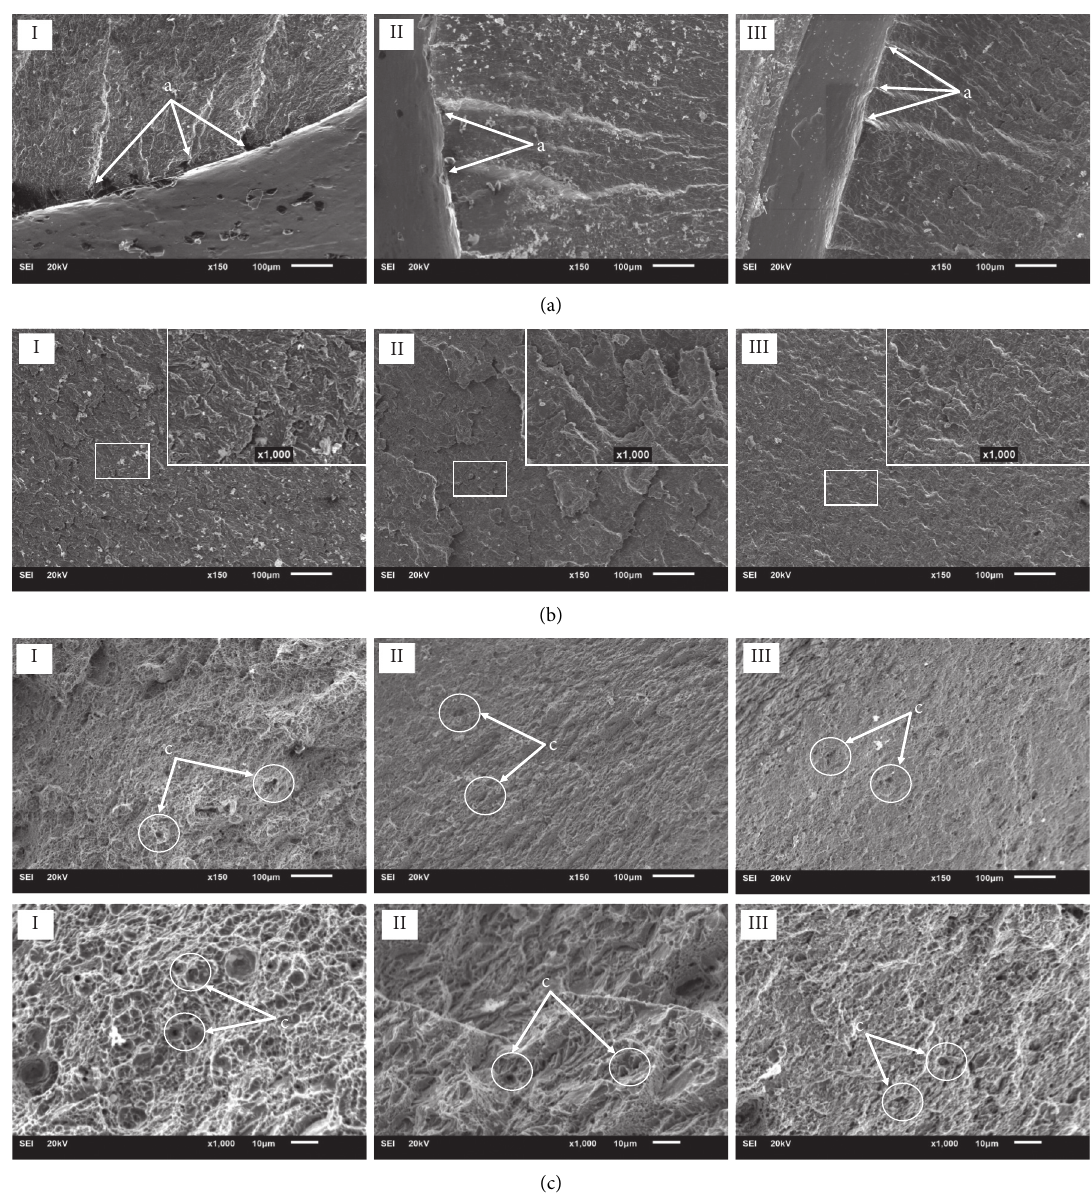
Figure 8: Micromorphology of bolt fracture: (a) crack source zone, (b) crack propagation zone, and (c) instantaneous fracture